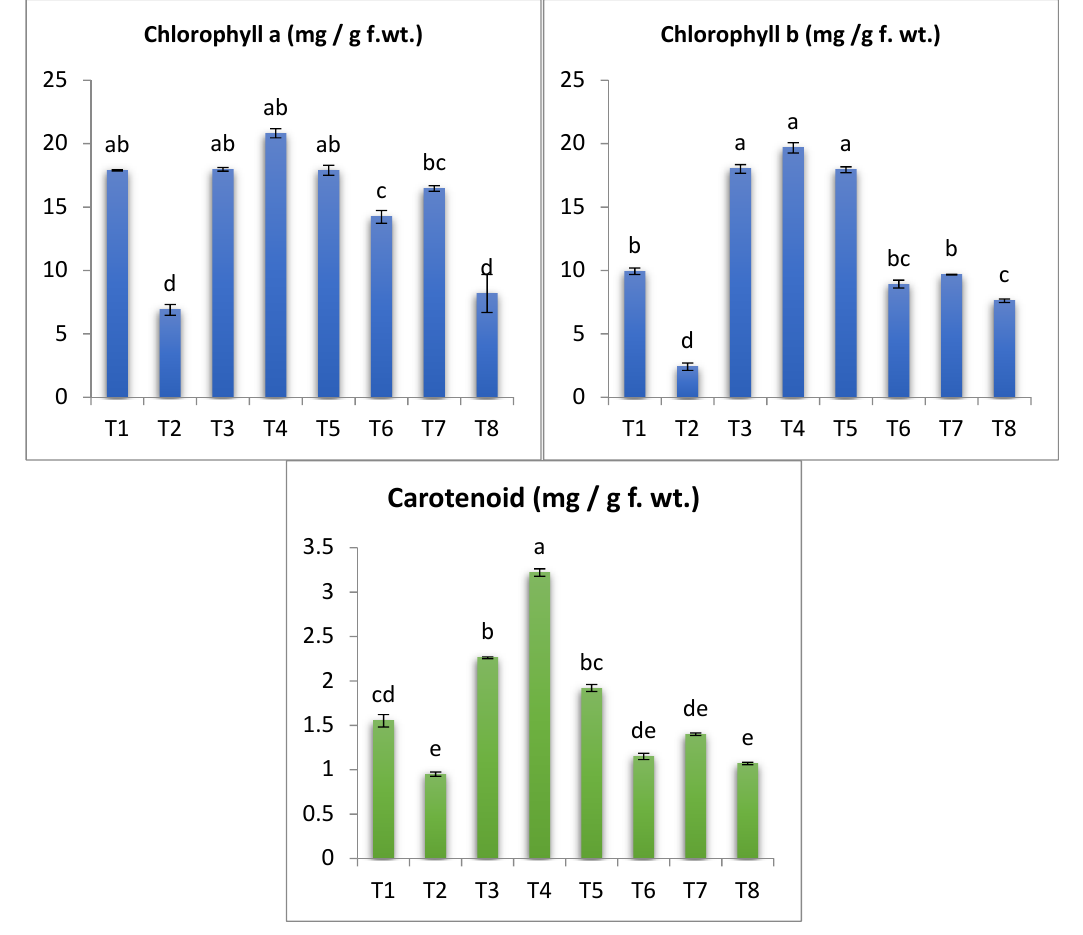
Figure 7. Effect of silica nanoparticles and SiO 2 on photosynthetic pigments of S. melongena. (Data represent mean ± SD, n = 3). (a–e revealed to significance letters).